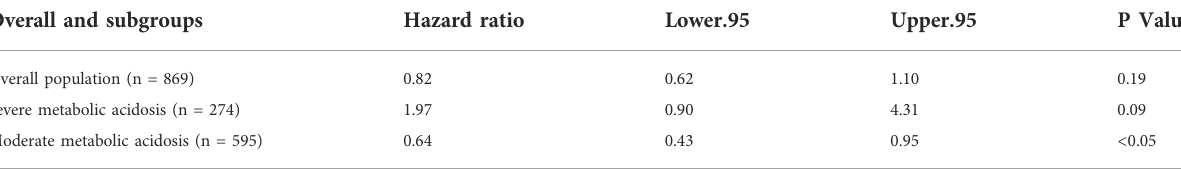
TABLE 2 Association of sodium bicarbonate infusion and ICU mortality in the overall and subgroups by using propensity score analysis. Overall and